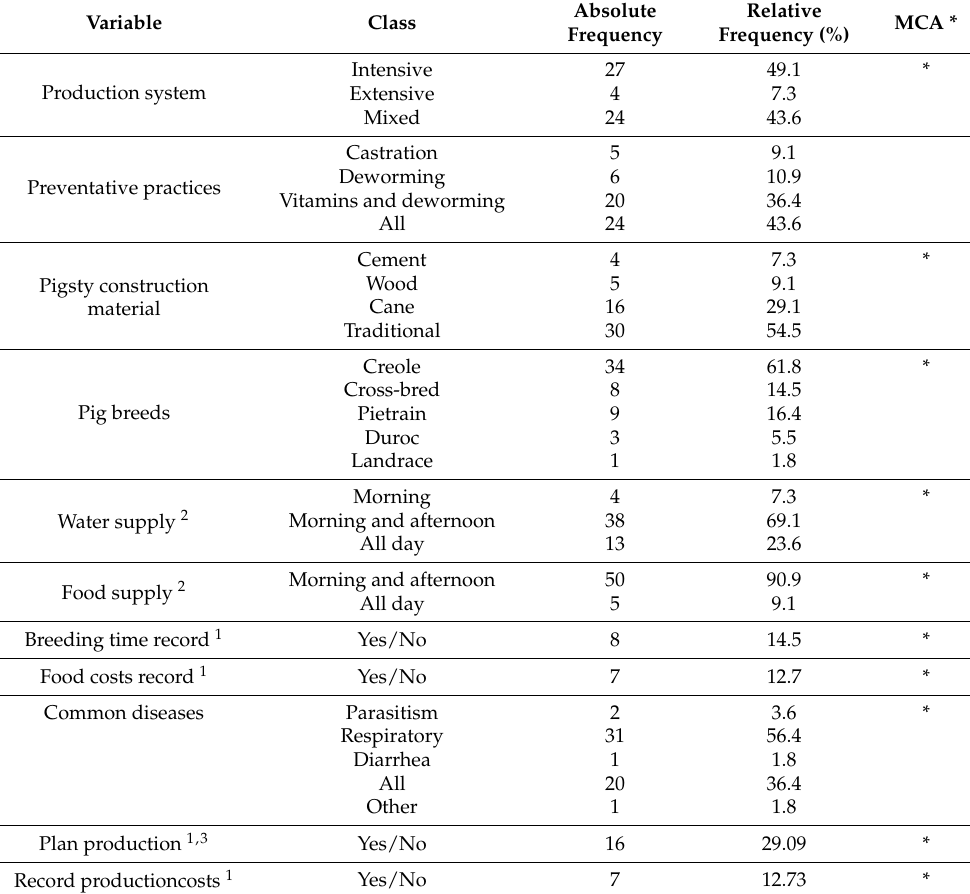
Table 2. Characteristics of the productive scope of small pig producers in communities of El Anegado parish, Jipijapa (N =